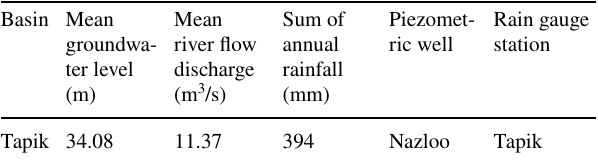
Table 1 Statistical characteristics of the studied data at an annual scale Basin Mean groundwa- ter level